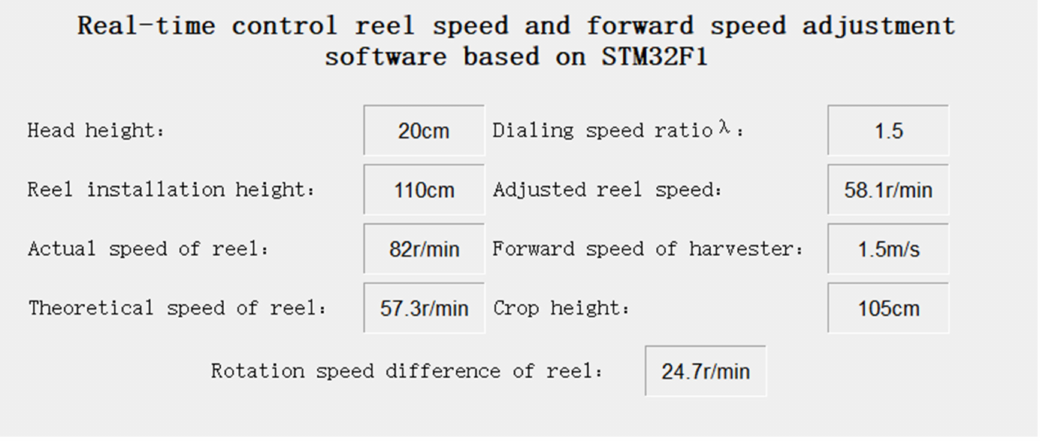
Figure 18. Control-system parameter collection